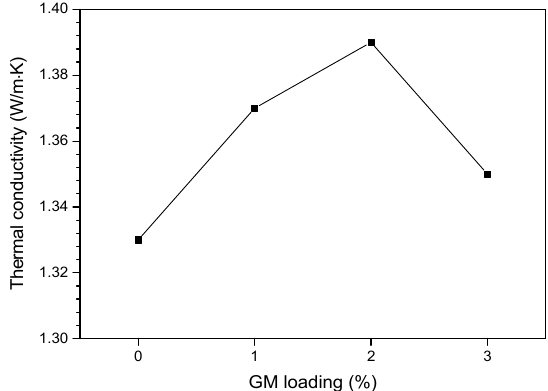
Figure 9. Thermal conductivity of CNC/GM coated wood samples as a function of GM loading.